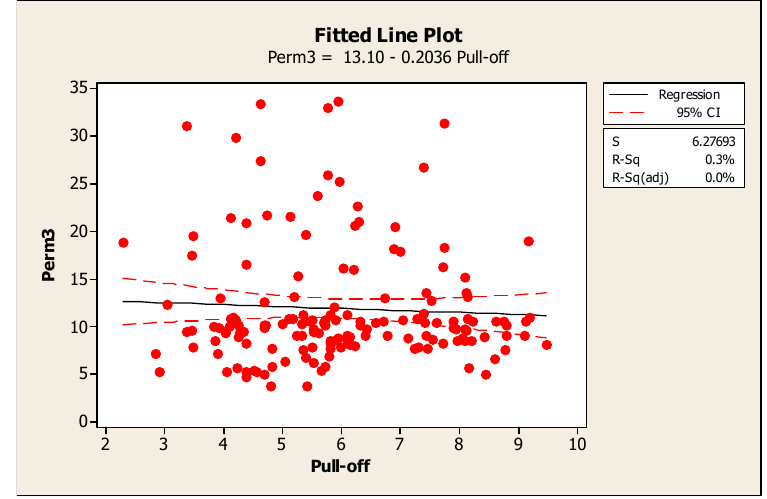
Figure 5. Fitted-line plot between pull-off adhesion strength versus specific air permeability (Perm3 = specific air permeability measured at the third vacuum pressure or water column level). Table 1. Regression analysis between longitudinal specific air permeability versus pull-off adhesion strength in different treatments.